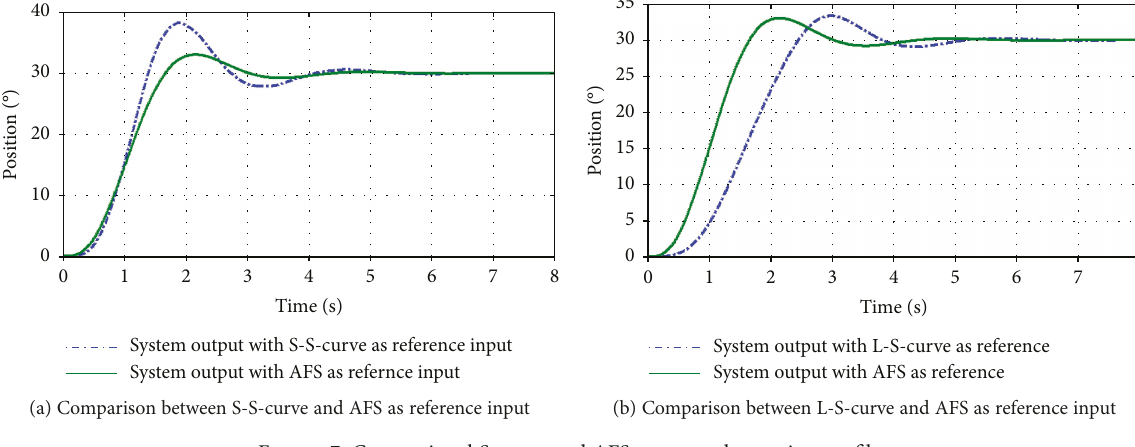
Figure 7: Conventional S-curve and AFS-curve as the motion pro fi le.